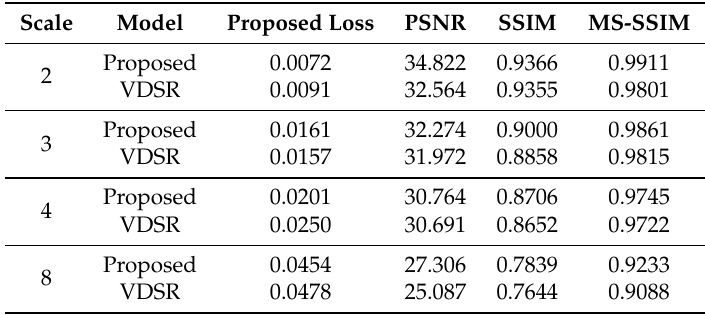
Table 1. Performance of the proposed SISR model ( Hydra trunk) and